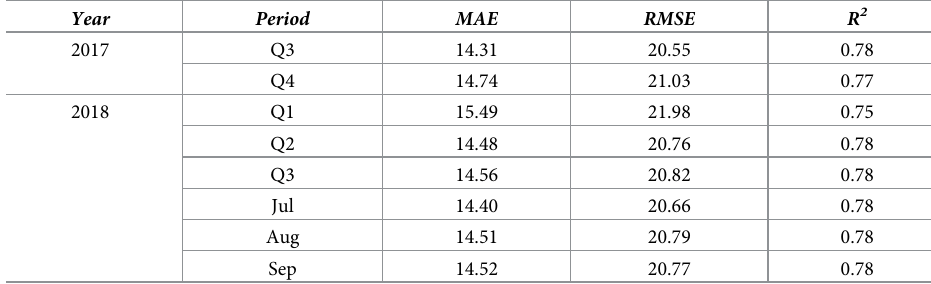
Table 1. Model-based ACD validation for all periods analyzed, showing the mean absolute error (MAE, Mg C ha - 1 ), root mean square error (RMSE, Mg C ha -1 ) and R 2